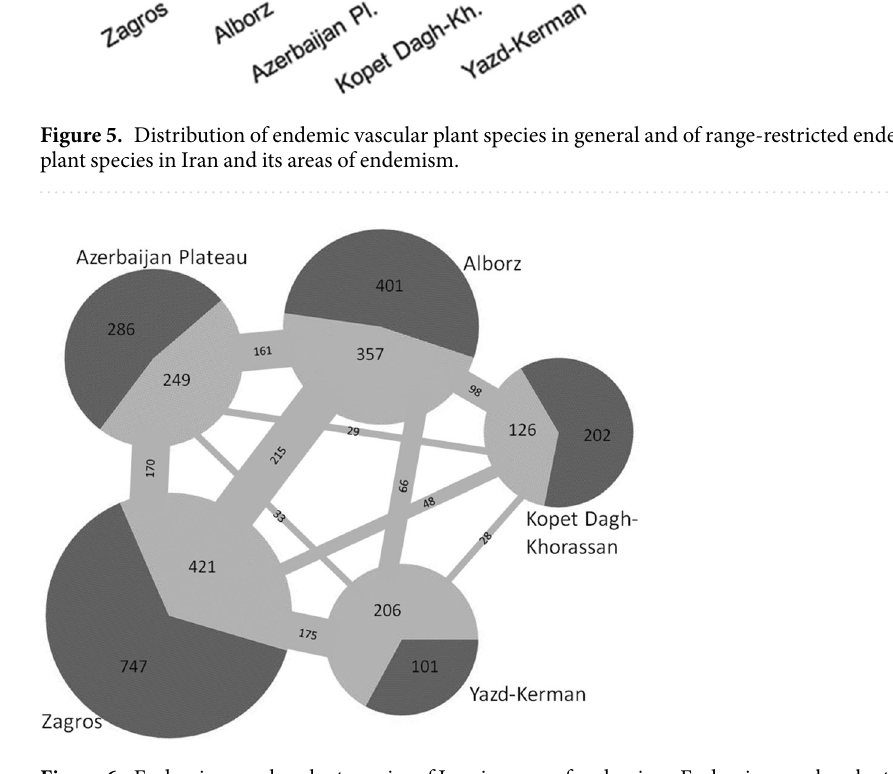
The second-richest area is Alborz, which harbours 29% of all Iranian vascular plant endemics nearly half of them being restricted to Alborz (Figs 5, 6 and Table 5). If taking area size into account, Alborz is richer than other regions. This is particularly evident for range-restricted endemics (here species which are only in maximally three grid cells of 0.5° × 0.5°), where, compared to Zagros, Alborz has half the number of endemics on one fifth the area (Fig. 5; Table 5). Generally, Central Alborz has the highest concentration of endemics in the Iranian Plateau (Noroozi et al . 2018). Alborz is a narrow, but very high and contiguous east-west oriented mountain range (Fig. 1) that borders on lowland deserts in the south and on the Caspian Sea in the north. A wide elevational range, high topographic complexity and strong environmental heterogeneity explain its high plant diversity and great rich- ness of endemics 19 . Alborz connects Kopet Dagh-Khorassan mountains in the east with the Azerbaijan Plateau and Zagros in the west (evident also in the high numbers of endemic species shared between Alborz and at least one of these regions; Fig. 6), thus acting as a corridor between Central Asia and Caucasus plus Anatolian moun- tains. Therefore, Alborz not only harbours a high number of local endemics, but also many elements showing biogeographic connections east- and/or westwards. In the Azerbaijan Plateau, 21% of Iranian vascular plant endemics are found, half of which are endemic to this area (Figs 5, 6 and Table 5). The Azerbaijan Plateau has a fragmented orography caused by different tectonic and volcanic activities 44 . Although three times larger than Alborz, the Azerbaijan Plateau contains fewer endemics